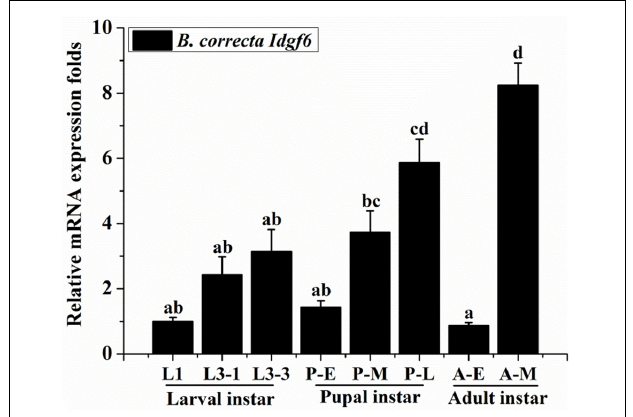
FIGURE 3 | The expression of Idgf6 at eight developmental stages of B. correcta . The eight developmental stages examined include the 1st instar larvae (L1, 2-day-old indicates 2 days post hatching), 3rd early instar larvae (L3-1, 5-day-old), 3rd instar larvae (L3-3, 7-day-old), early pupae (P-E, 1-day-old indicates 1 day post pupating), medium pupae (P-M, 5-day-old), and late pupae (P-L, 9-day-old), early adults (A-E, 1 day post eclosion) and late adults (A-M, 10 days post eclosion). The results are presented as the relative expression after normalization against the endogenous 18S rRNA gene. Expression is relative to the gene expression in 1 st instar larvae (assigned a value of 1), and the same letter means there are no significant differences. Different letters above the bars represent significant differences at P < 0.05, as determined by ANOVA followed by Tukey’s HSD